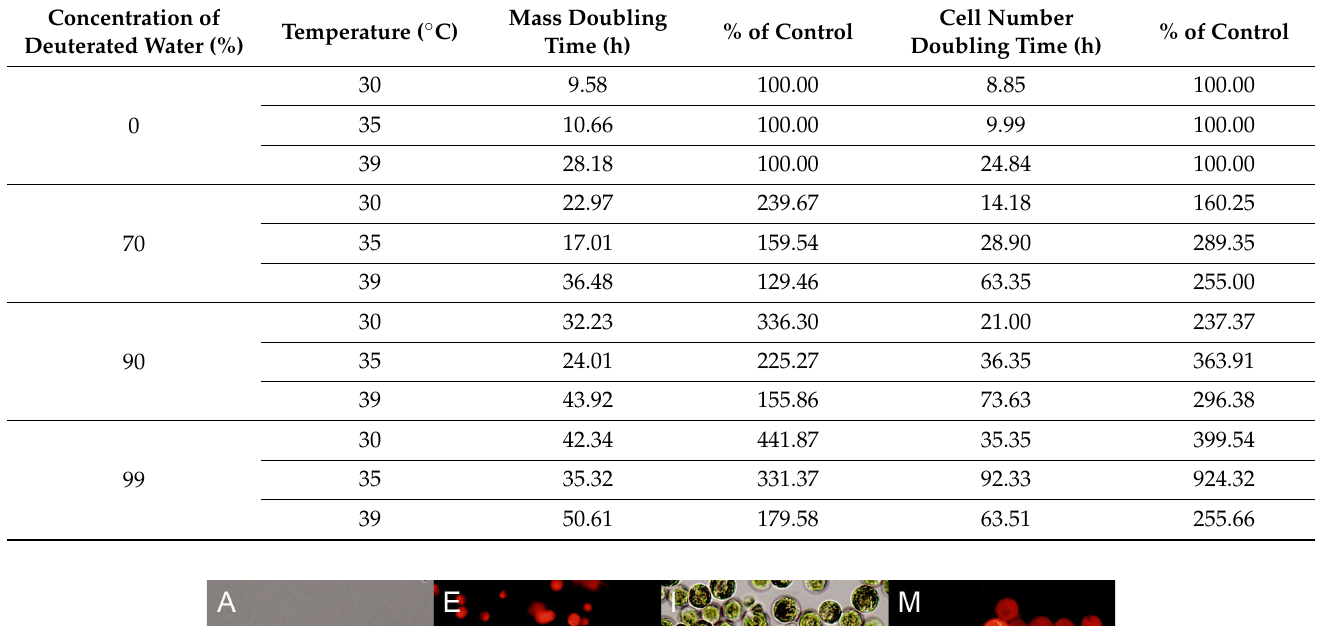
Table 2. Comparison of mass and cell number doubling times for cultures grown in media containing different concentrations of deuterated water at different temperatures. The average of at least three experiments is shown.